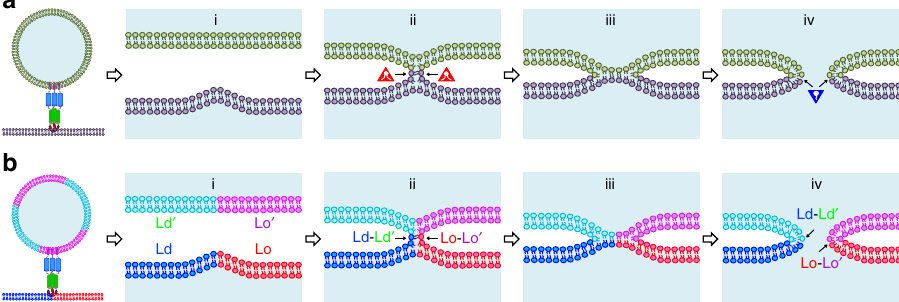
Figure 8 | Extension of stalk-pore model of membrane fusion to heterogeneous lipid bilayers containing lipid rafts. ( a ) Schematic diagrams illustrating different steps of membrane fusion in the standard stalk-pore model with homogeneous membranes: (i) close contact of two lipid bilayers with point-like protrusion, (ii) lipid stalk connecting two bilayers, (iii) hemifusion diaphragm and (iv) fusion pore. Lipids with negative spontaneous curvature (red triangles) stabilize the stalk and lipids with positive spontaneous curvature (blue inverted triangles) stabilize the fusion pore. ( b ) Stalk-pore model extended to fusion of lipid bilayers with coexisting Lo/Ld domains. The domain boundaries generate additional energy for membrane fusion by reduction of line tension energy. These boundaries induce local curvature and defects that facilitate fusion peptide insertion at different steps in the extended stalk-pore model (see text, for more